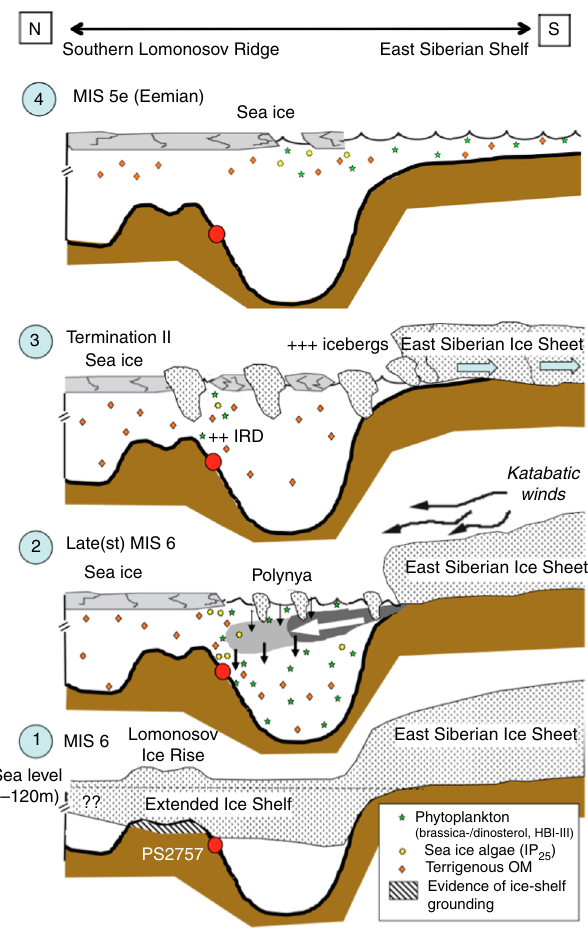
Fig. 6 Cartoon of different paleoenvironmental scenarios of sea ice and ice sheet extent at the East Siberian Continental Margin/Southern Lomonosov Ridge area. These scenarios are (1) to (4) based on the biomarker records from Core PS2757-8 (Fig. 2c). (1) MIS 6 scenario with an extended East Siberian Ice Sheet and ice shelf/rise. Under such conditions, neither phytoplankton productivity nor terrigenous organic matter ( OM ) input occur as re fl ected in the absence of the biomarkers, and total sedimentation may have decreased to zero. Hatched fi eld marks area on southern Lomonosov Ridge where traces of erosion by grounding ice were recorded as SE-NW oriented streamlined bedforms on the Lomonosov Ridge at water depths between 800 and 1000 m (ref. 8 ; cf., Supplementary Fig. 7). (2) Late MIS 6 with the ice sheet still reaching the shelf edge, with a polynya situation caused by strong katabatic winds. Quite stable ice-edge conditions resulted in increased fl uxes of IP 25 , open-water phytoplankton and terrigenous biomarkers (cf., Supplementary Fig. 1). (3) Phase of major retreat and decay of the ice sheet resulting in high sediment (IRD) input by calving icebergs. (4) Last Interglacial (MIS 5e/Eemian) with a more or less closed sea ice cover situation over Core PS2757-8, preventing phytoplankton and sea ice algae productivity, and probably ice-free conditions towards the East Siberian shelf. The occurrence of phytoplankton, sea ice algae and terrigenous biomarkers are indicated by green stars , yellow stars and orange rhombs , respectively. Red circle